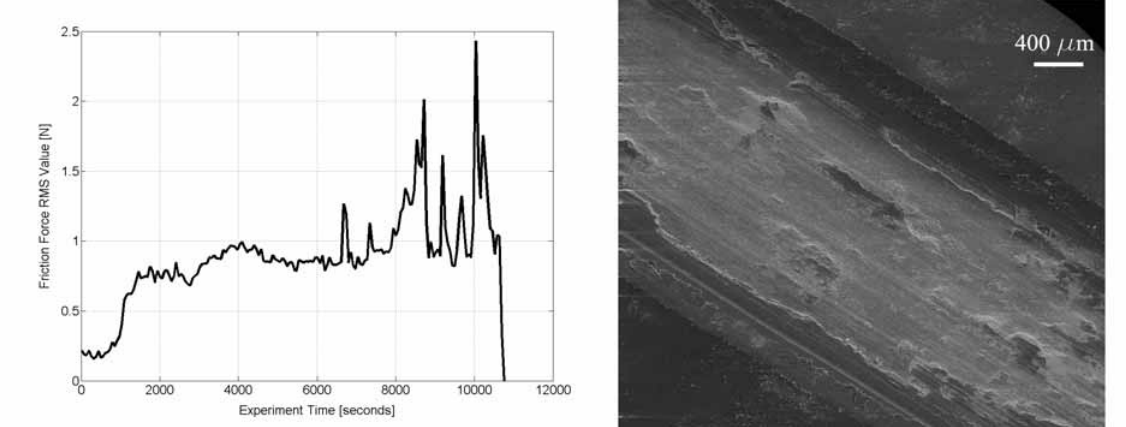
Fig. 17. Estimated friction force and surface SEM photography: Class III